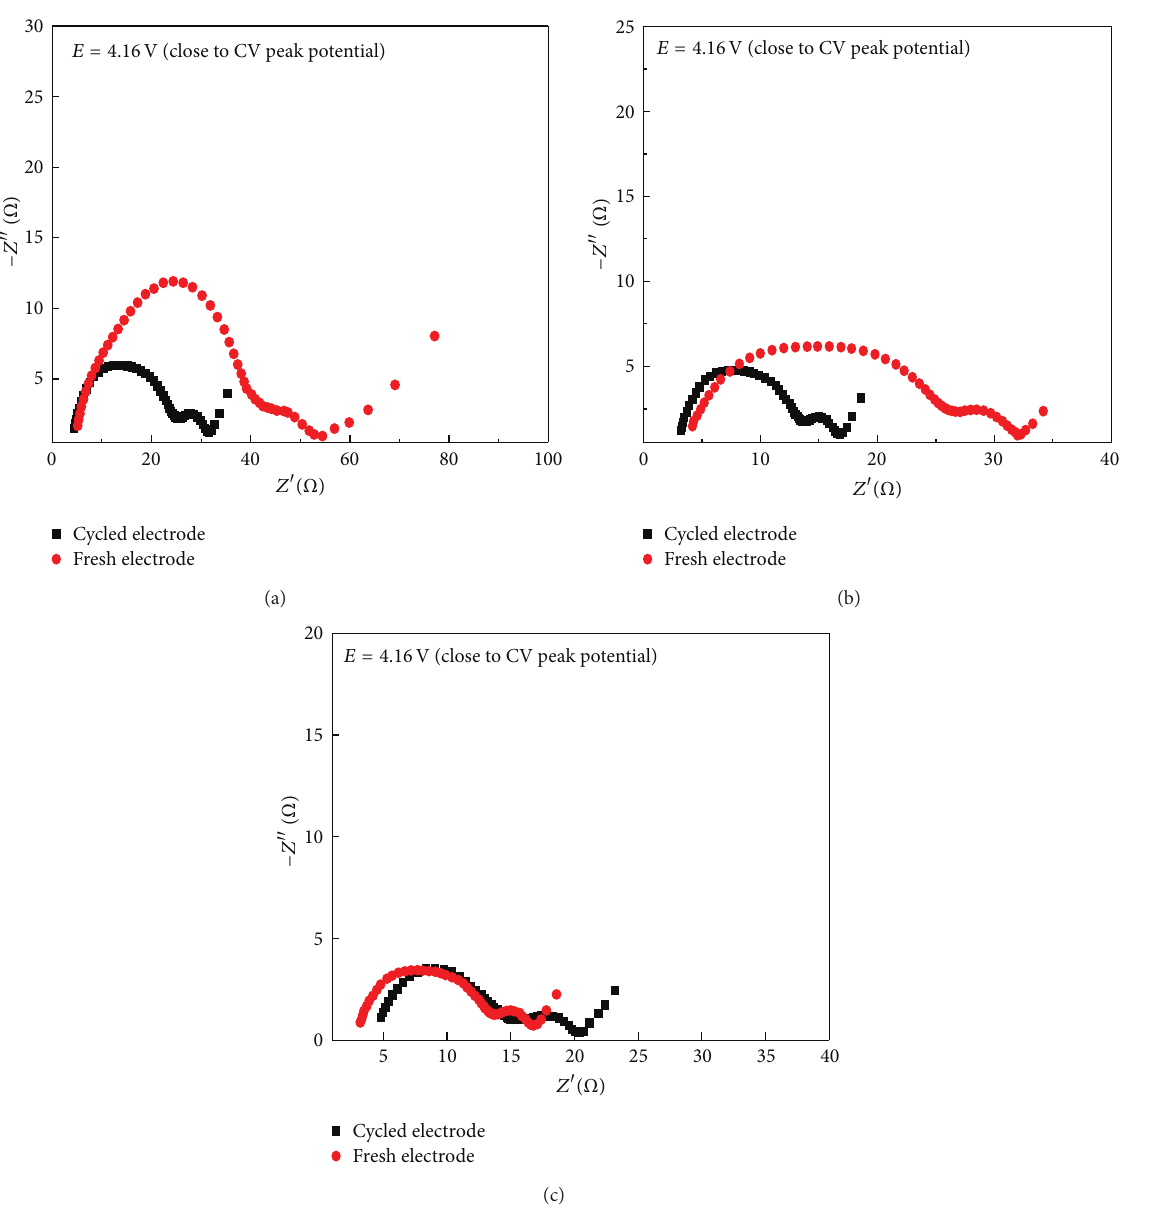
Figure 6: AC impedance experiments measured for the spinel (a) Li/LiMn 2 O 4 , (b) Li/Li 1.02 Mn 1.92 Al 0.02 Fe 0.02 Cr 0.02 O 4 , and (c) Li/Li 1.02 Mn 1.92 Al 0.02 Fe 0.02 Cr 0.02 O 3.92 F 0.08 electrodes at the potential 𝐸 = 4.16 V before and after 50